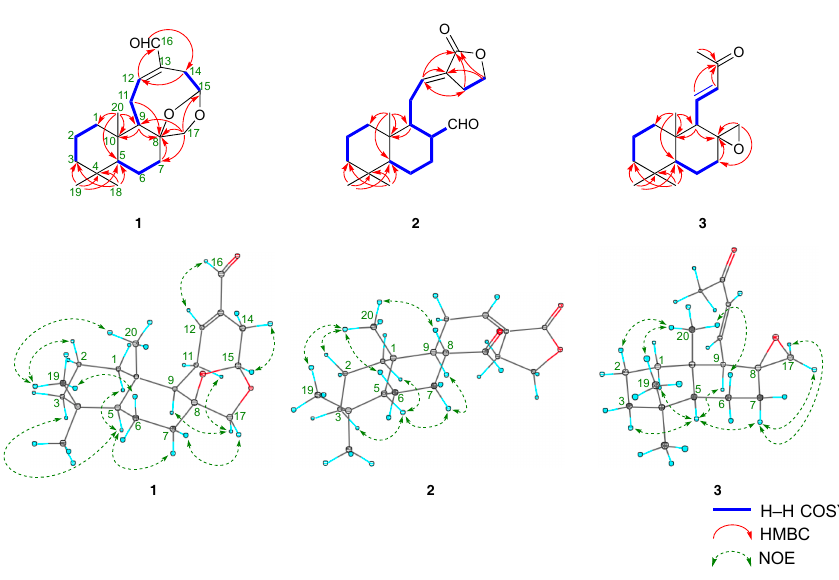
Figure 2. 1 H– 1 H COSY, HMBC, and NOESY correlations of 1 – 3 .